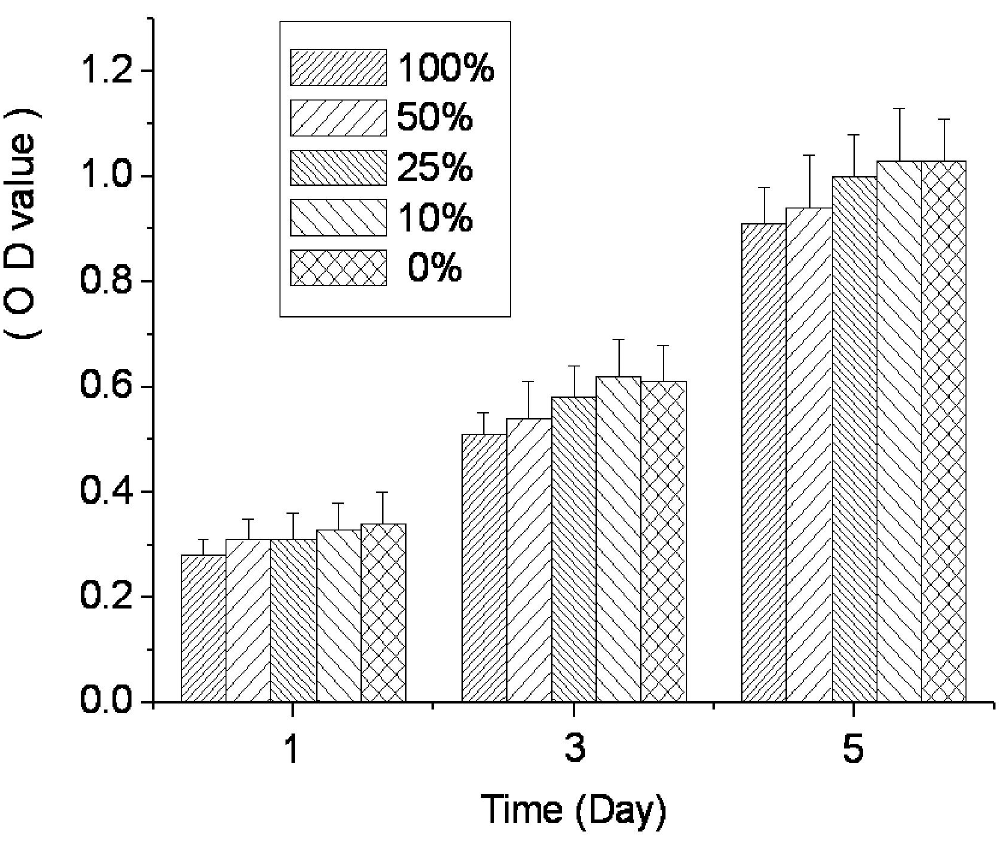
Figure 6. RGR of L929 cell showed as OD values in the cytotoxicity test of Sr-doped ABS.